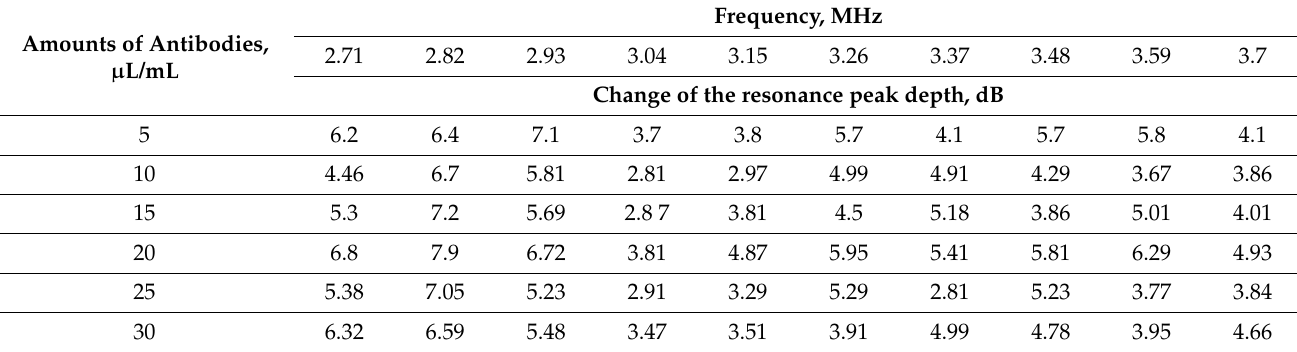
Table 1. Change in the depth of all resonance peaks observed on the frequency dependence of the insertion loss of the sensor. Amounts of antibodies, μ L/mL